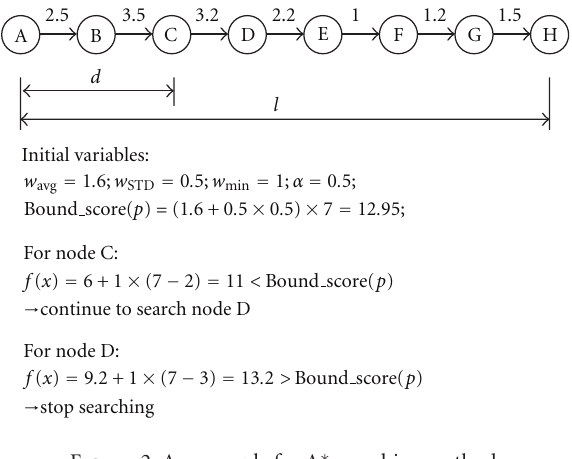
Figure 2: An example for A ∗ searching method.